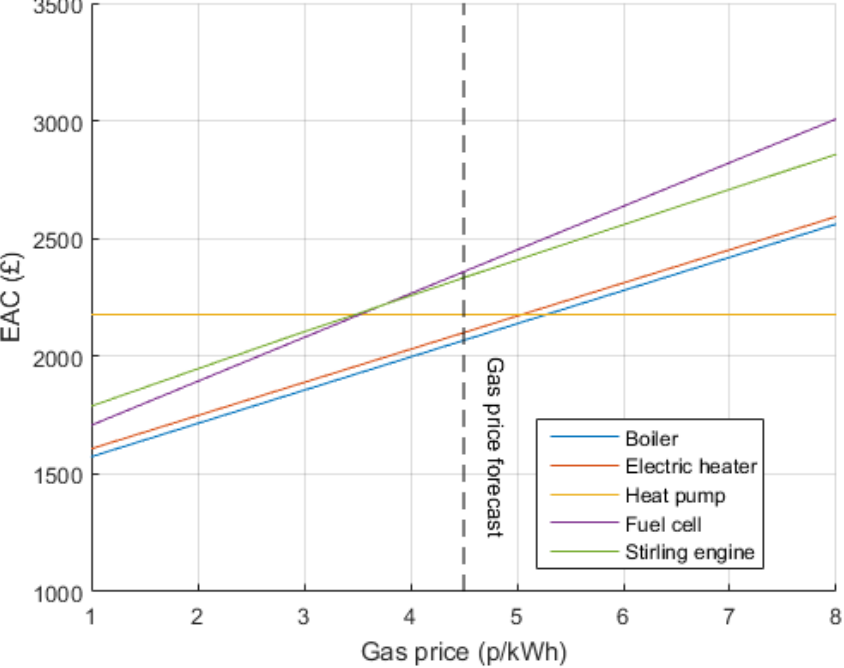
Figure 10. Equivalent Annual Cost sensitivity to natural gas price in the short run electricity price regime.